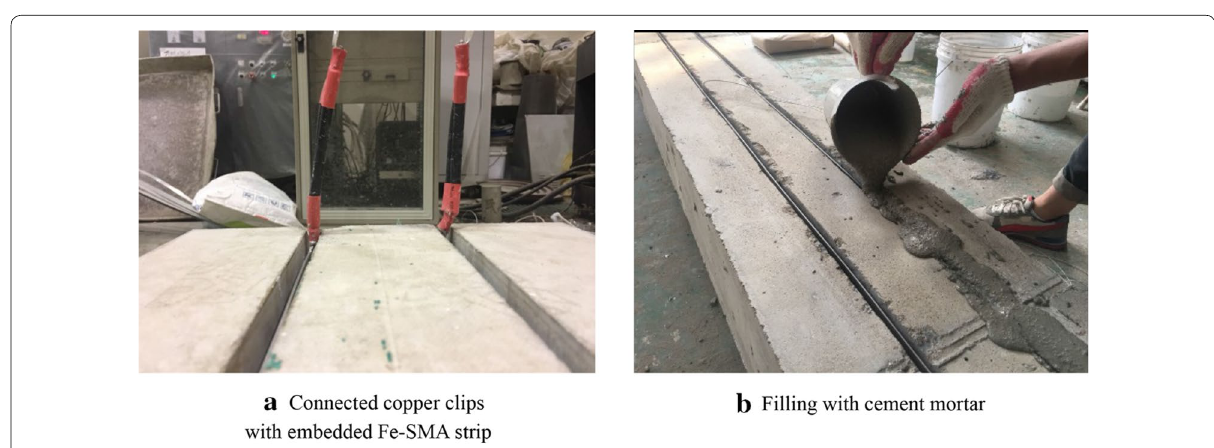
Fig. 6 Details of the bonded Fe-SMA inside the concrete beam.